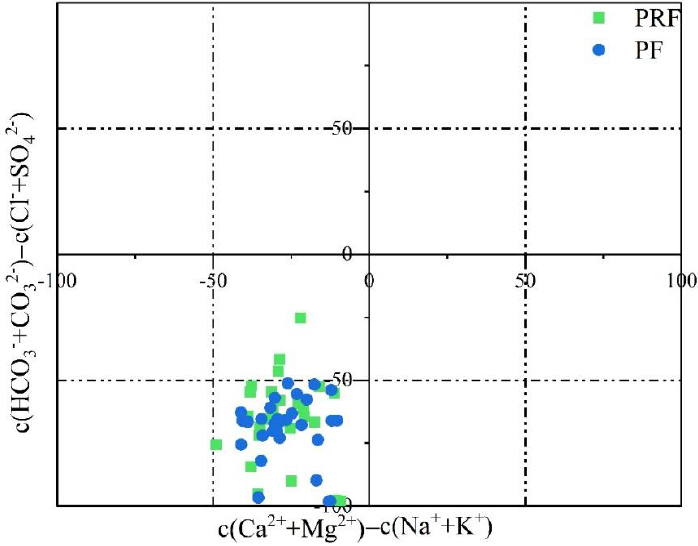
Figure 5. Groundwater types and their variation pre-flood (PRF) and post-flood (POF).